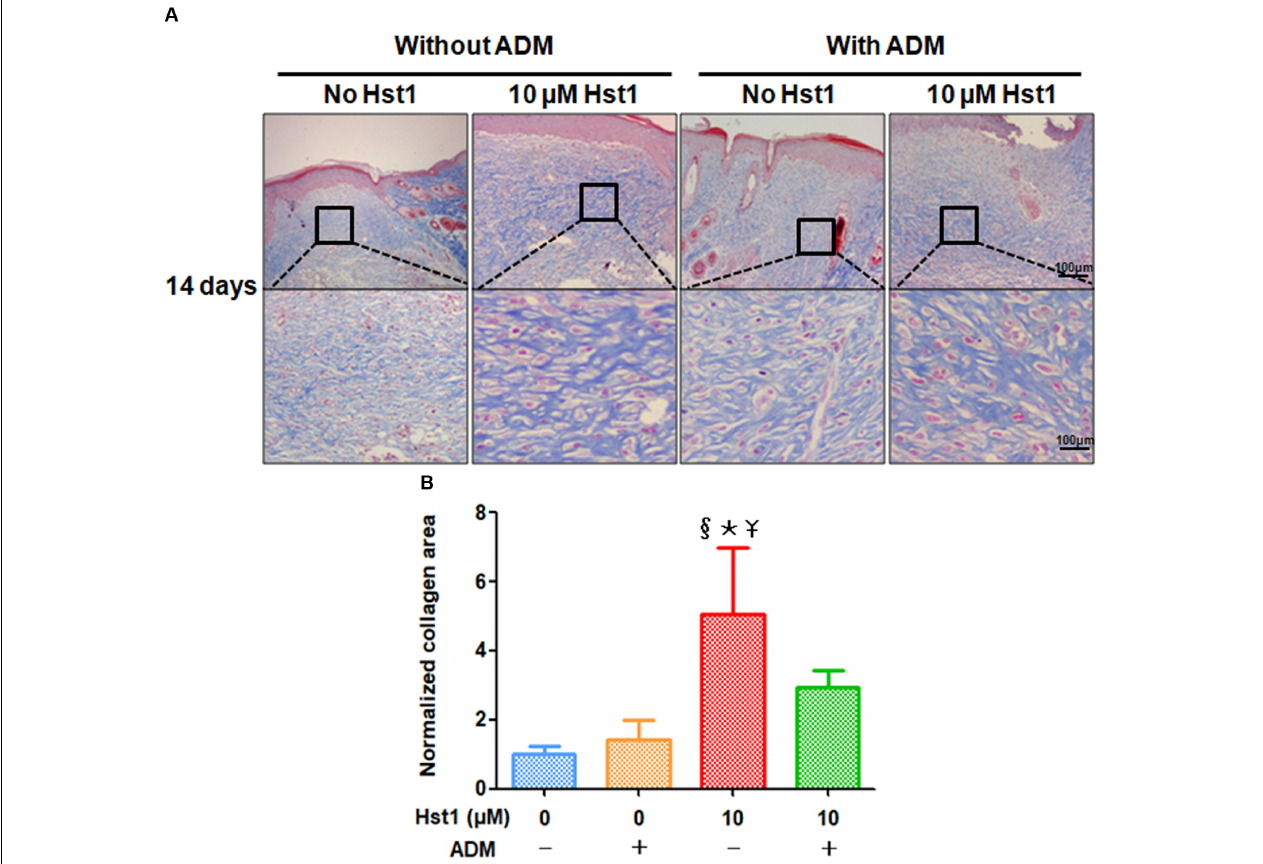
FIGURE 3 | Masson staining evaluation of collagen fibers deposited in newly formed epidermal layer. (A) 14 days post-surgery, the collagen fibers in the 10 µ M Hst1 group deposited massively and arranged regularly. Blue represented the positive expression. The scare bar = 100 µ m; (B) Quantitative analysis by normalizing collagen area in treatment groups to the control group. The collagen regeneration area in the 10 µ M Hst1 group was significantly larger compared with the other groups, while either ADM or ADM + 10 µ M Hst1 didn’t significantly influence collagen area. §: The 10 µ M Hst1 group vs the control group; *: The 10 µ M Hst1 group vs the ADM group; –Y: The 10 µ M Hst1 group vs the 10 µ M Hst1 + ADM group (P <